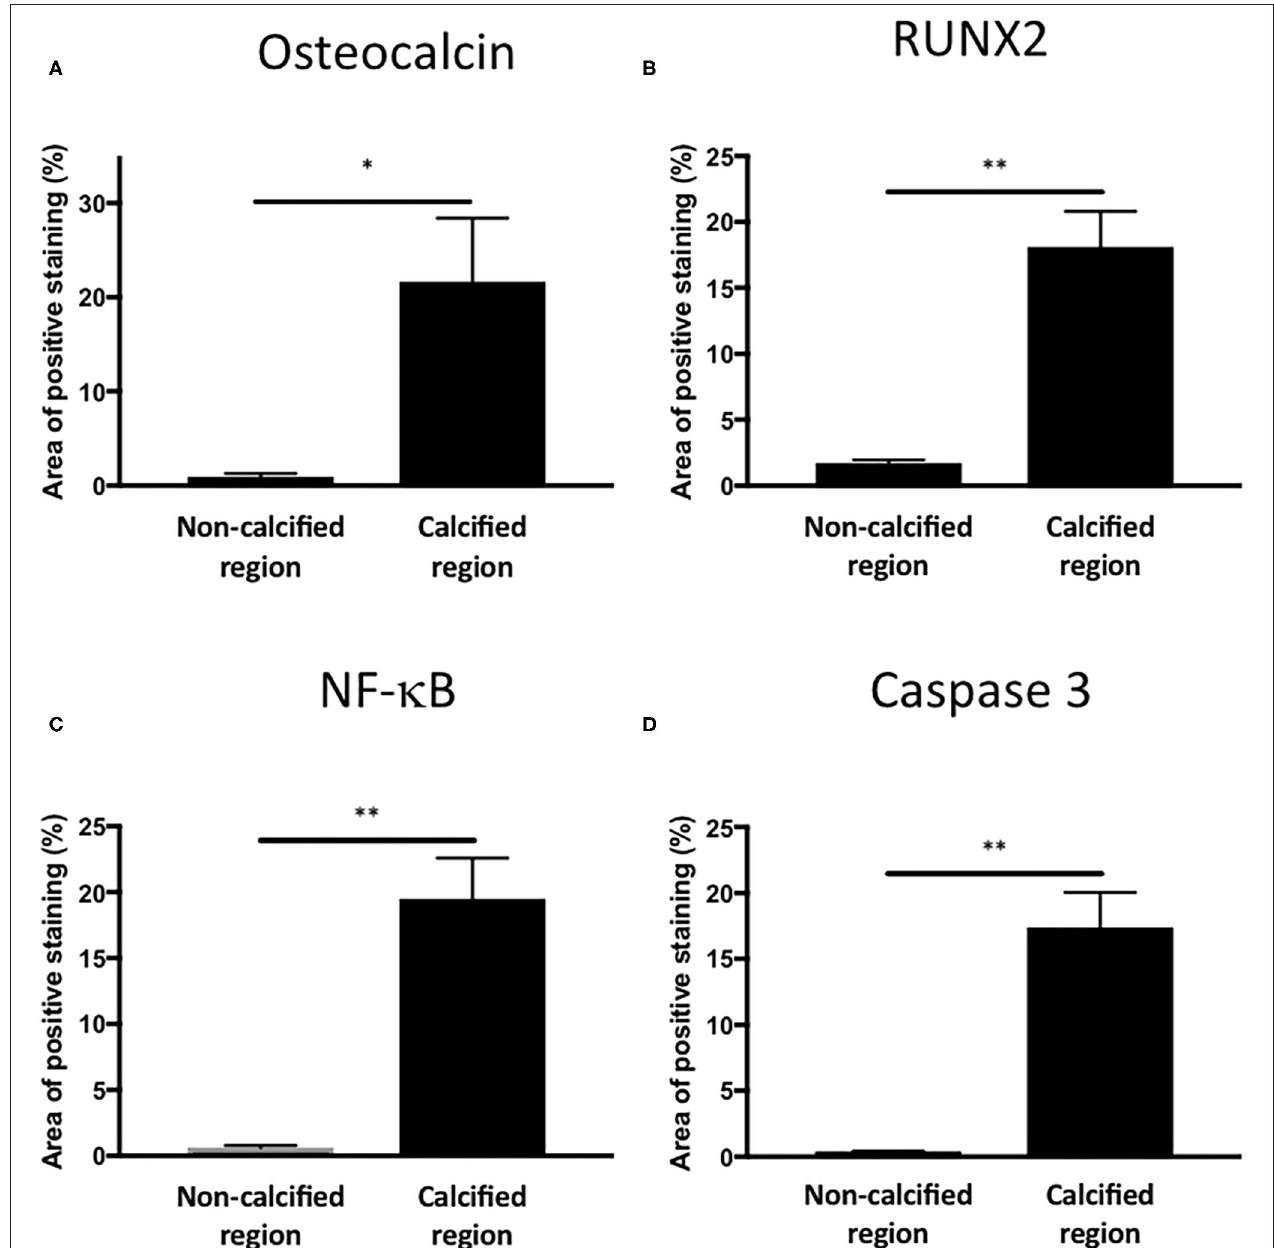
FIGURE 8 | Quantification of osteogenic, inflammatory and apoptotic markers in Alizarin Red positive and negative areas of valve leaflets. Percentage area staining of 1.1 mm 2 regions from non-calcified and calcified regions for (A) osteocalcin (* P = 0.012, T -Test; n = 4), (B) RUNX2 (** P < 0.001, T -Test; n = 4), (C) NF-kB (** P < 0.001, T -Test; n = 4) and (D) caspase 3 (** P < 0.001, T -Test; n =